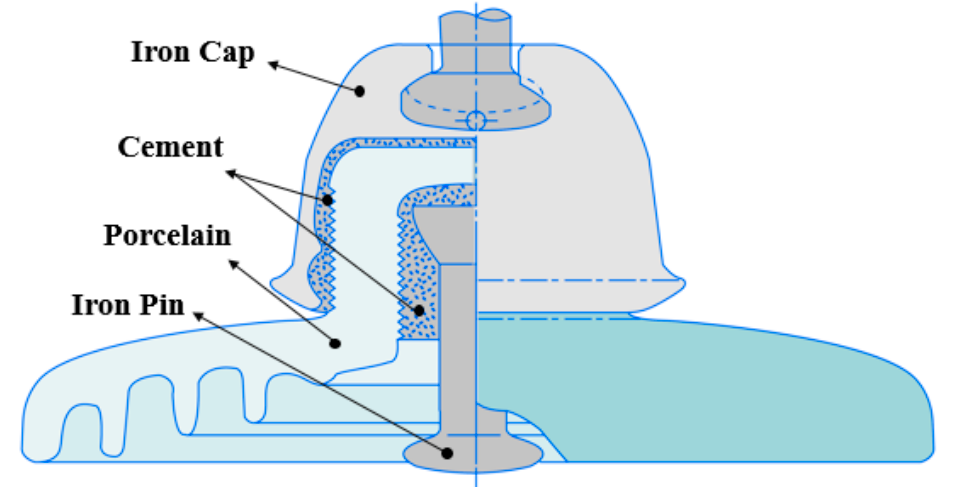
Figure 1. Section showing the four components of the porcelain insulator.